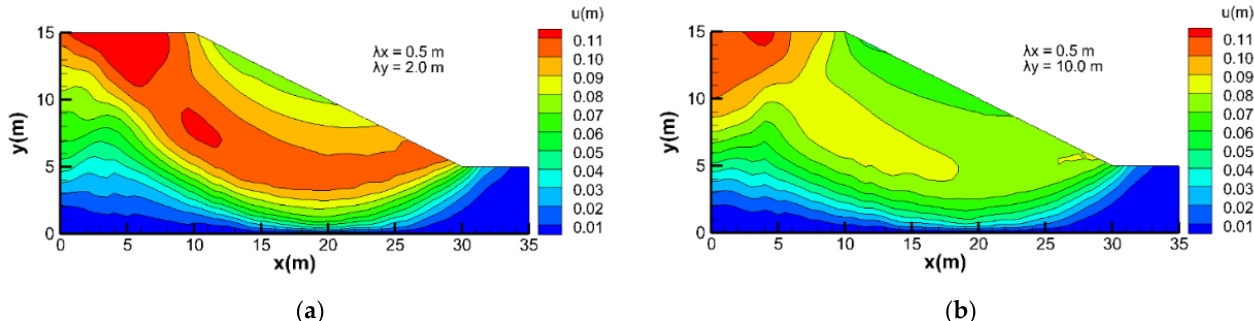
Figure 9. The contour map of the displacement of vertical layered slopes with different λ y : ( a ) λ y = 2 m and ( b ) λ y = 10 m.